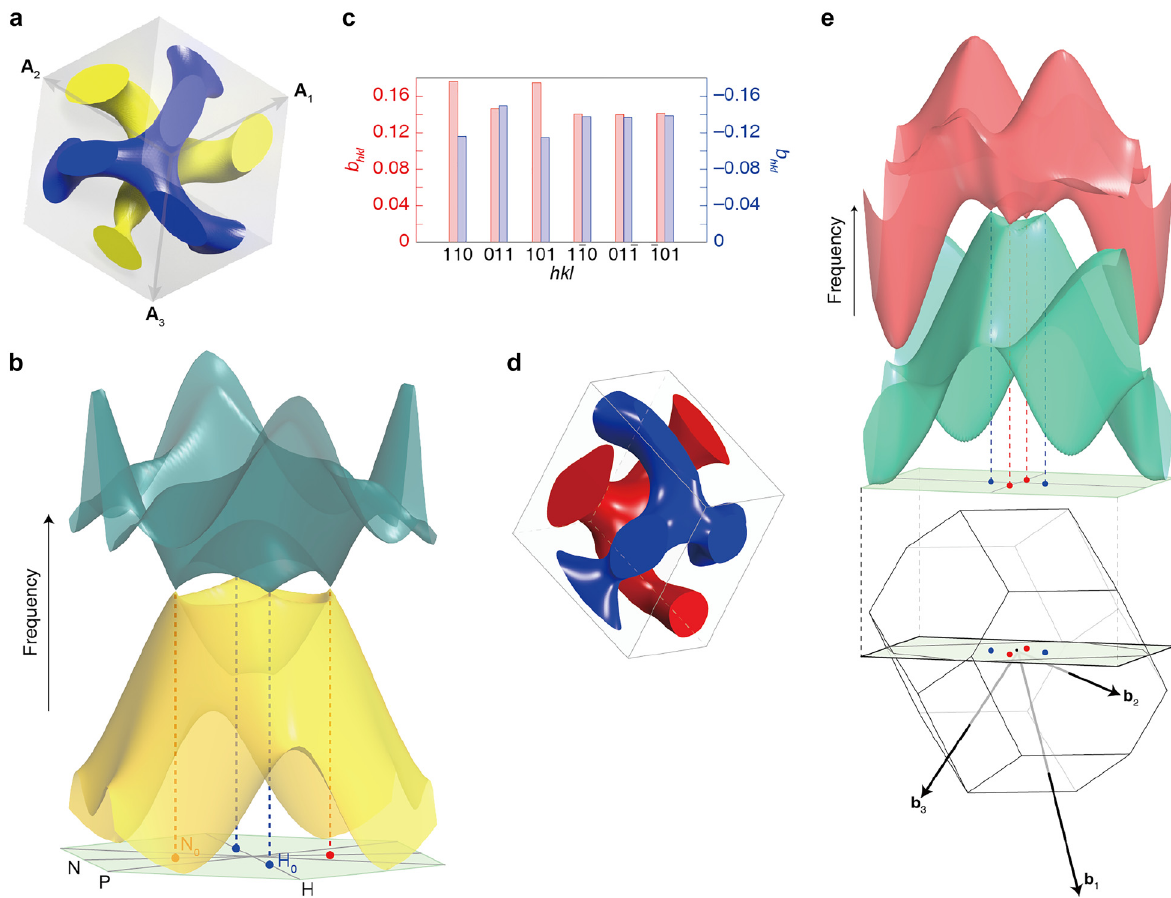
Figure 12: Weyl points formation via modifications of f SG (X). (a) Double gyroid comprising perturbed (yellow) and unperturbed (blue) single gyroids. Refractive indices of these are identically 4.0. (b) Photonic bandstructureexhibitingWeylpoints.(c)and(d)Level-setanalysisfortwosinglegyroidsofBCPdoublegyroidanditsillustration.Redandbluebars in (c) detail the red and blue single gyroids in (d), respectively. The six b hkl values for each single gyroid correspond to the coef fi cients of Eq. (42). (e)Weylpointsinphotonicbandstructureofdoublegyroidexpressedby(c)and(d).Thisnumericalcomputationconsideredthatrefractiveindicesof single gyroids in (d) are both 4.0. Structure was assumed as the deformed double gyroid. Reproduced with permission from ref. [30]. Copyright 2020, American Chemical Society (a) and (b); reproduced with permission from ref. [35]. Copyright 2021, Elsevier B.V. (c) –